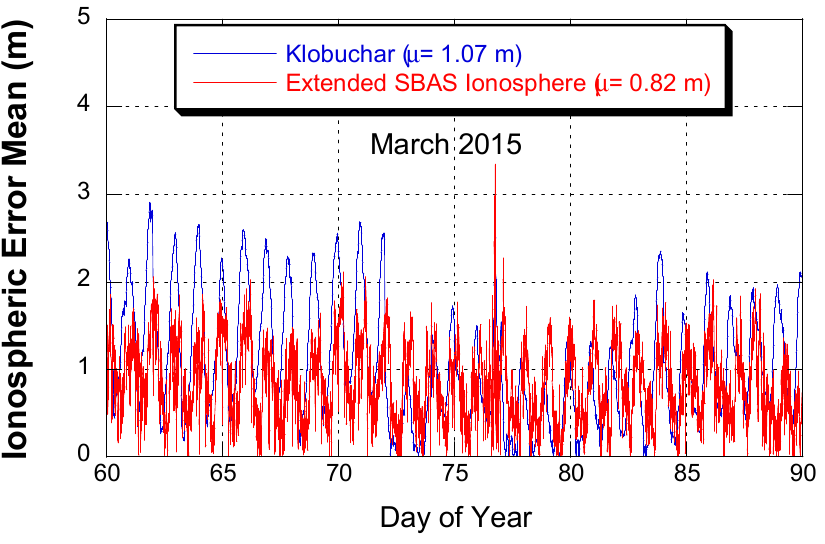
Figure 6. Time series of daily ionosphere error mean of the extended WAAS and Klobuchar models in March 2015.